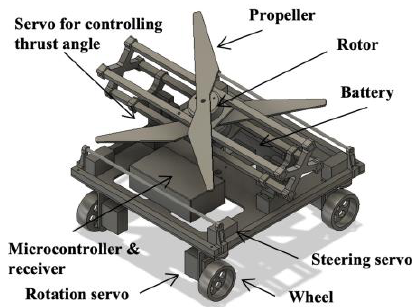
Figure 2. Computer-aided design of the proposed robot.